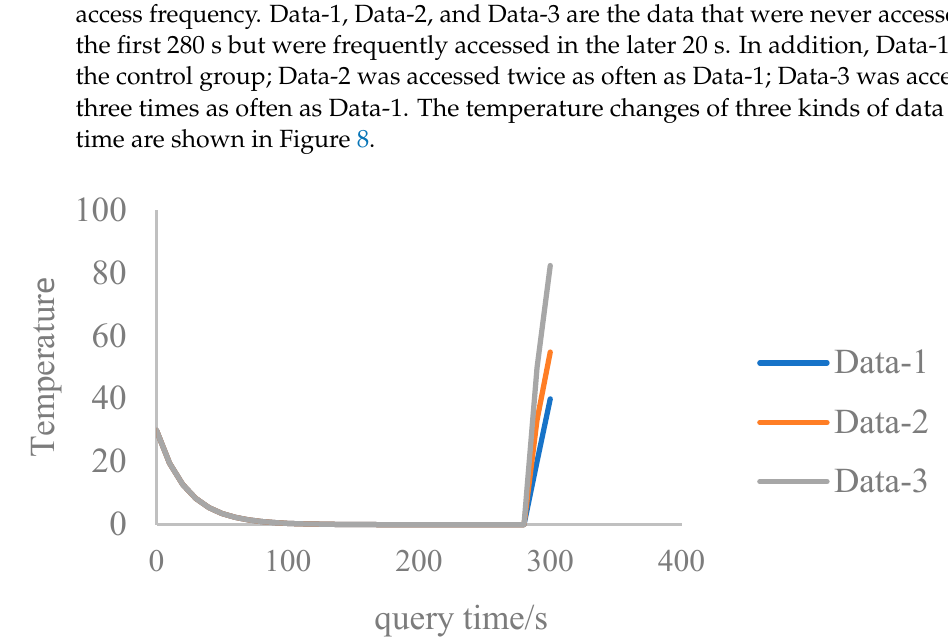
Figure 8. Influence of access frequency on temperature in S-TCR method.